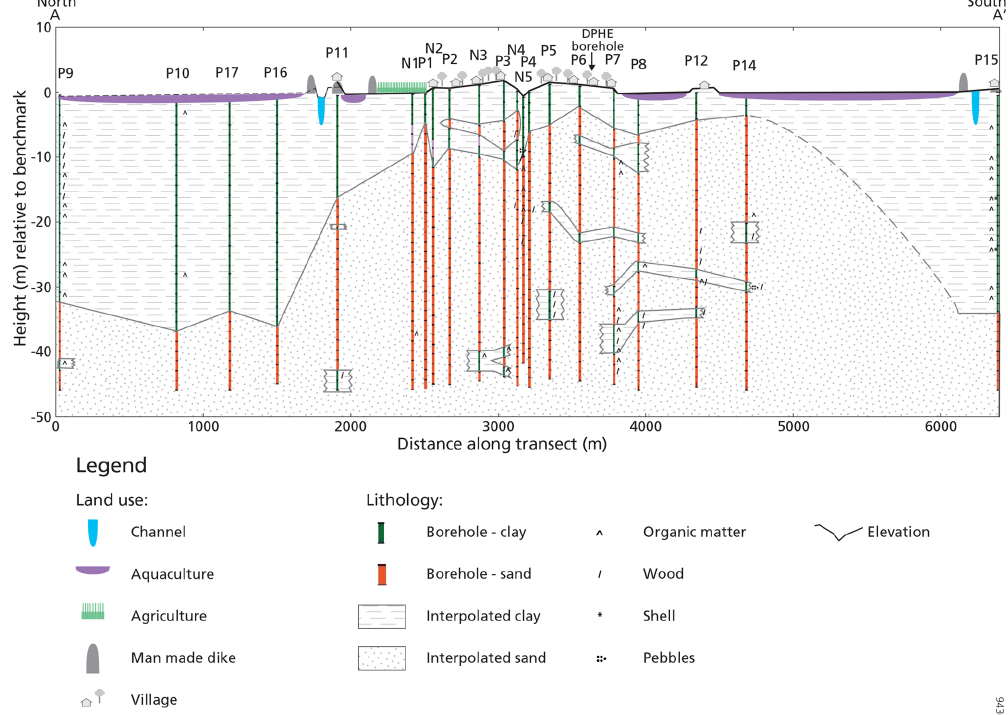
Figure 2. Lithological data from the boreholes drilled in this study, and the interpolated sand and clay layers. A clear difference in thickness of the clay layer is visible between the palaeo floodplains at the northern and southern sides of the transect, and the palaeo-channel in the middle of the